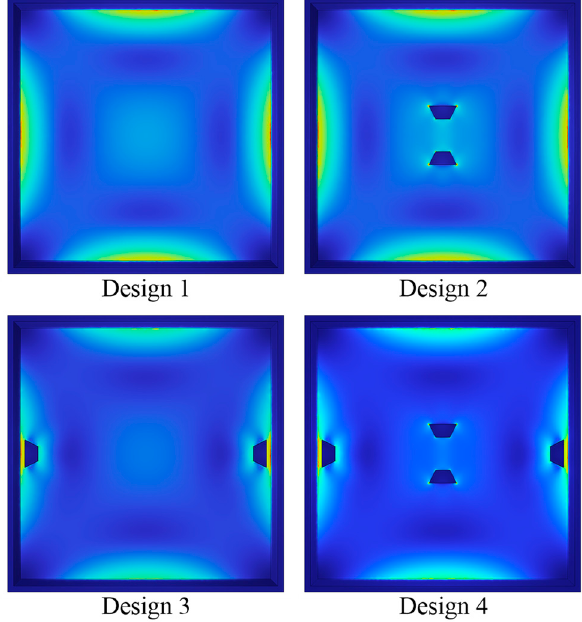
Figure 10. The four structures for simulation comparison. Table 7. Comparison of center deflection for the four structures under different applied pressures.